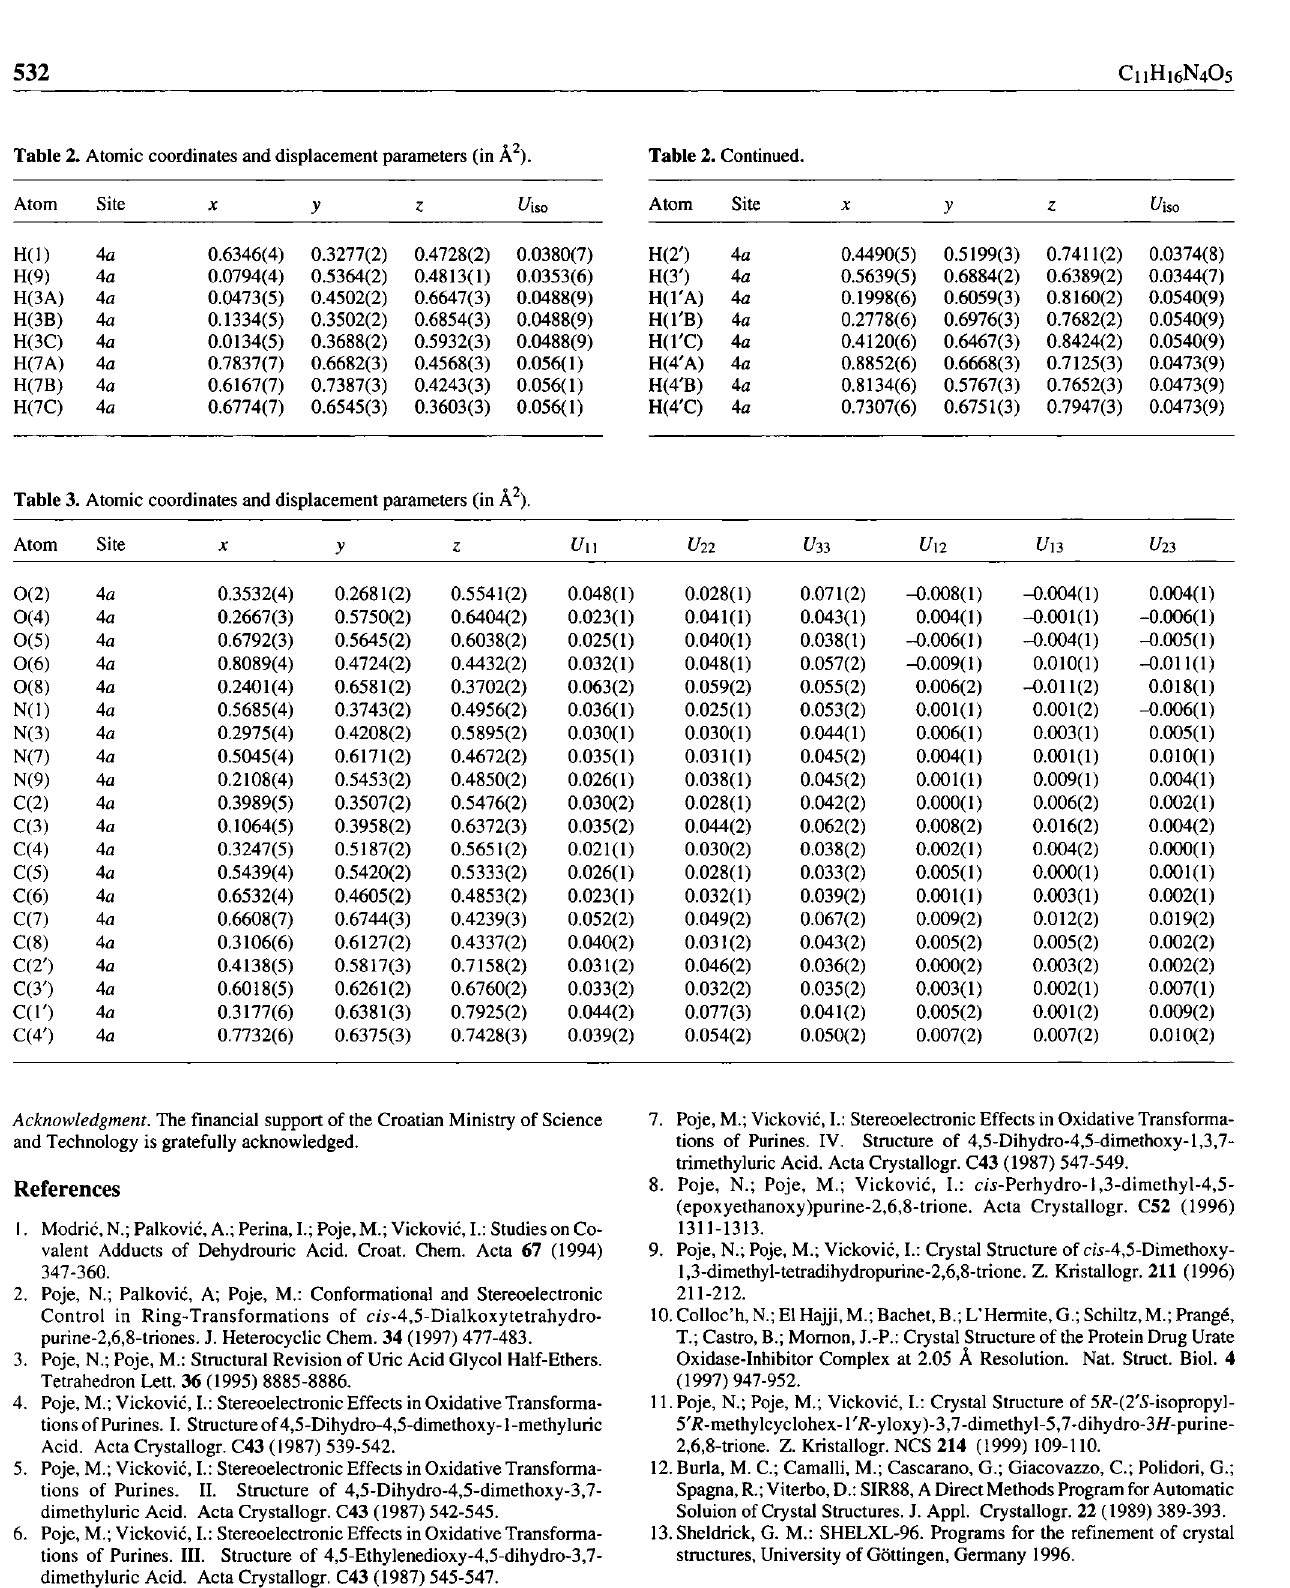
Table 2. Atomic coordinates and displacement parameters (in Ä 2 ). Table 2. Continued.